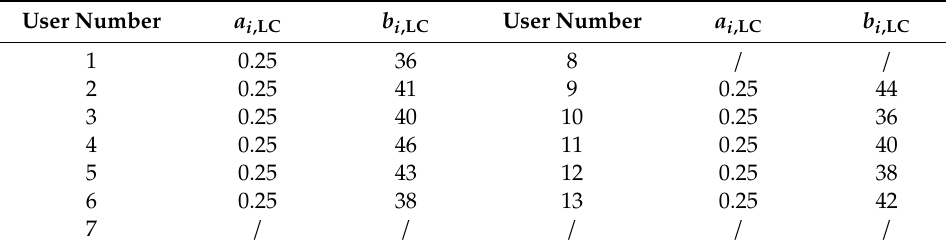
Figure A2. Profiles of predicted electricity load and electricity shortage. Table A2. Parameters of response cost of all users.